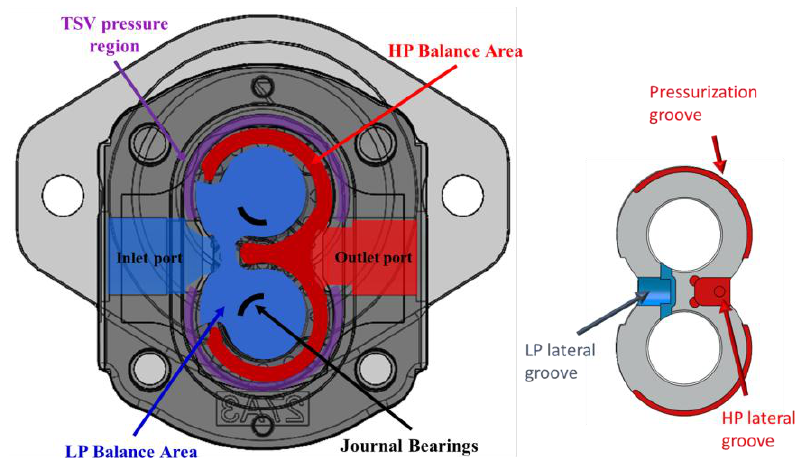
Figure 7. Regions exposed to the pressure in external gear pumps.